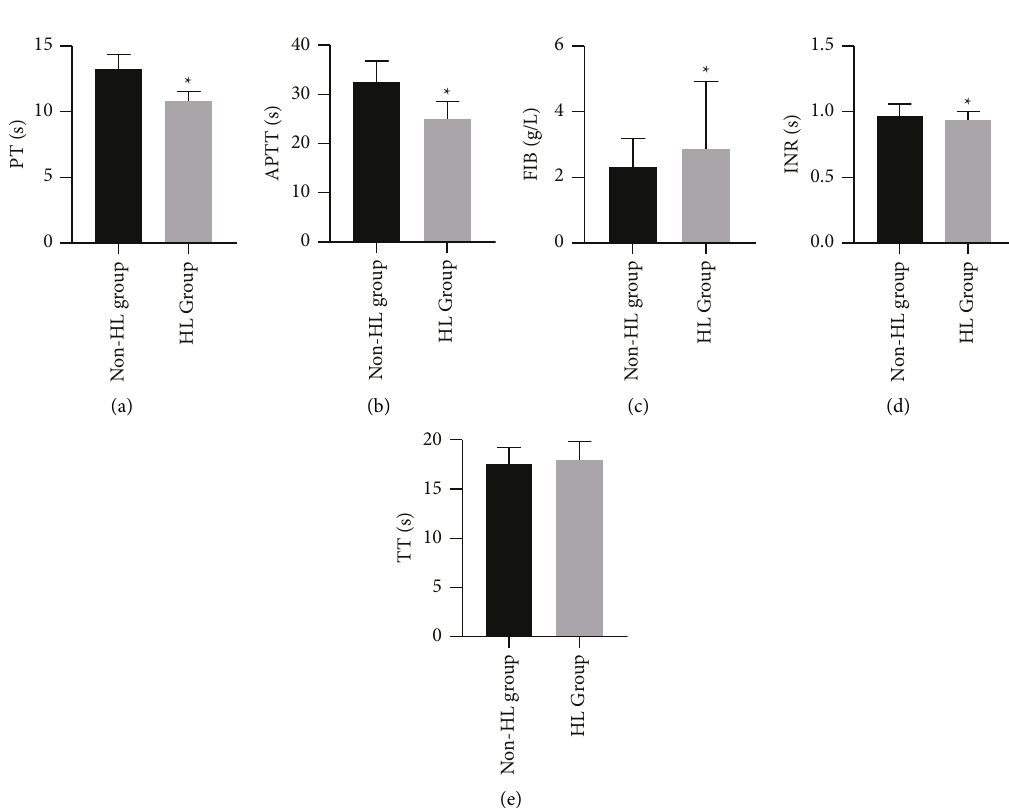
Figure 2: Comparison of coagulation test indexes. Note: ∗ indicates P < 0 . 05.